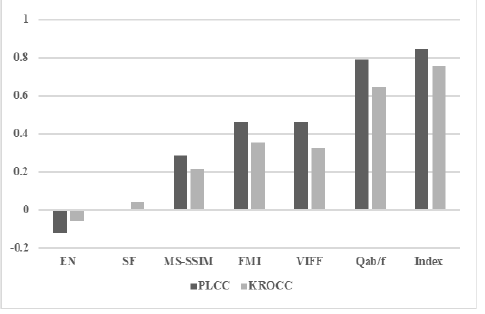
Figure 2. The PLCC and SROCC values chart.